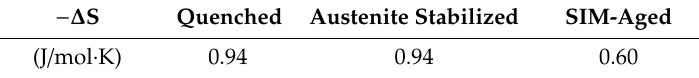
Table 2. Values of the transformation entropy, − ∆ s , calculated from the DSC curves for the quenched, austenite stabilized (annealed at 573 K for 6 h) and SIM-aged Ni 51 Fe 18 Ga 27 Co 4 single crystals. The numbers are averaged values for heating and cooling and the error bars are about ± 0.08 J / mol · K, within which, the values for heating and cooling were also the same. − ∆